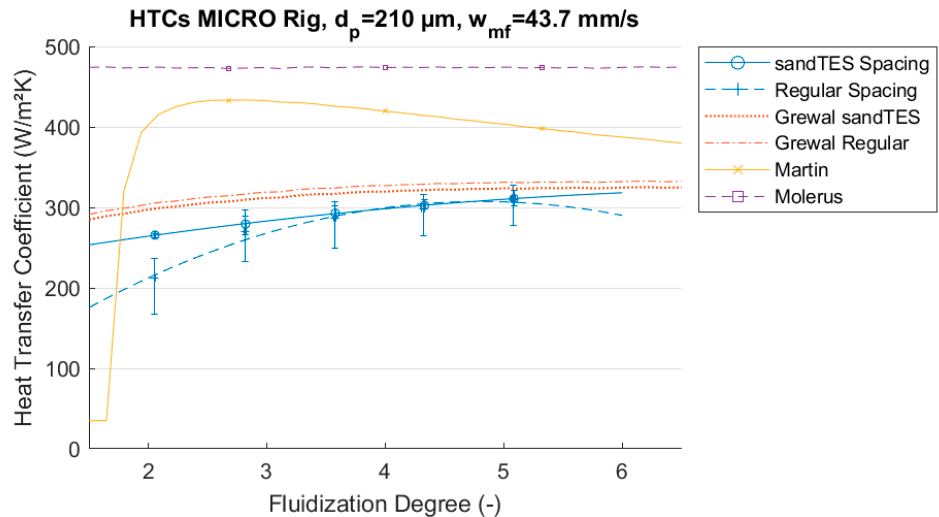
Figure 21. Comparison of MICRO results with 210 µm particles.